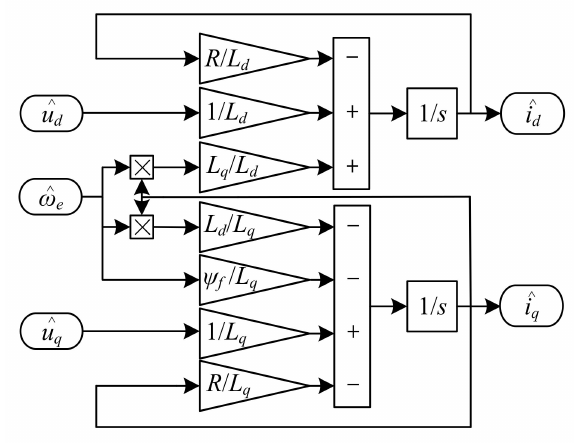
Figure 5. A diagram of the current observer of the d–q